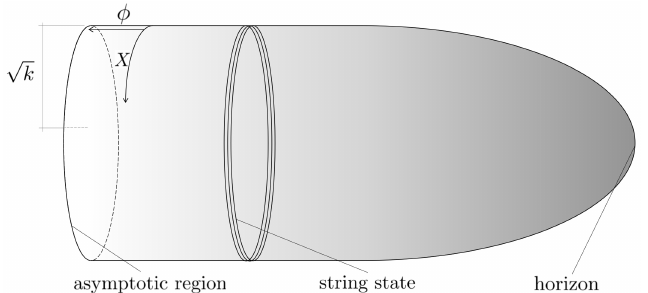
Figure 2 . The geometry of the Euclidean 2D black hole resembles a semi-infinite cigar of radius √ k in string units ( α 0 = 1 here). The black hole horizon corresponds to the tip of the cigar. The string non-linear σ -model on this space is given by the SL(2 , R ) k / U(1) WZW model. The theory on AdS 3 can be described by tensoring SL(2 , R ) k / U(1) ×